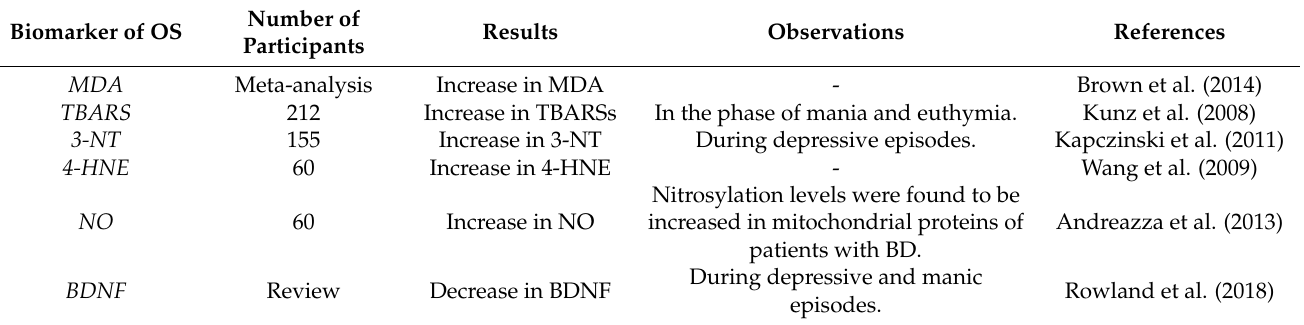
Table 2. Summary of OS biomarkers in bipolar